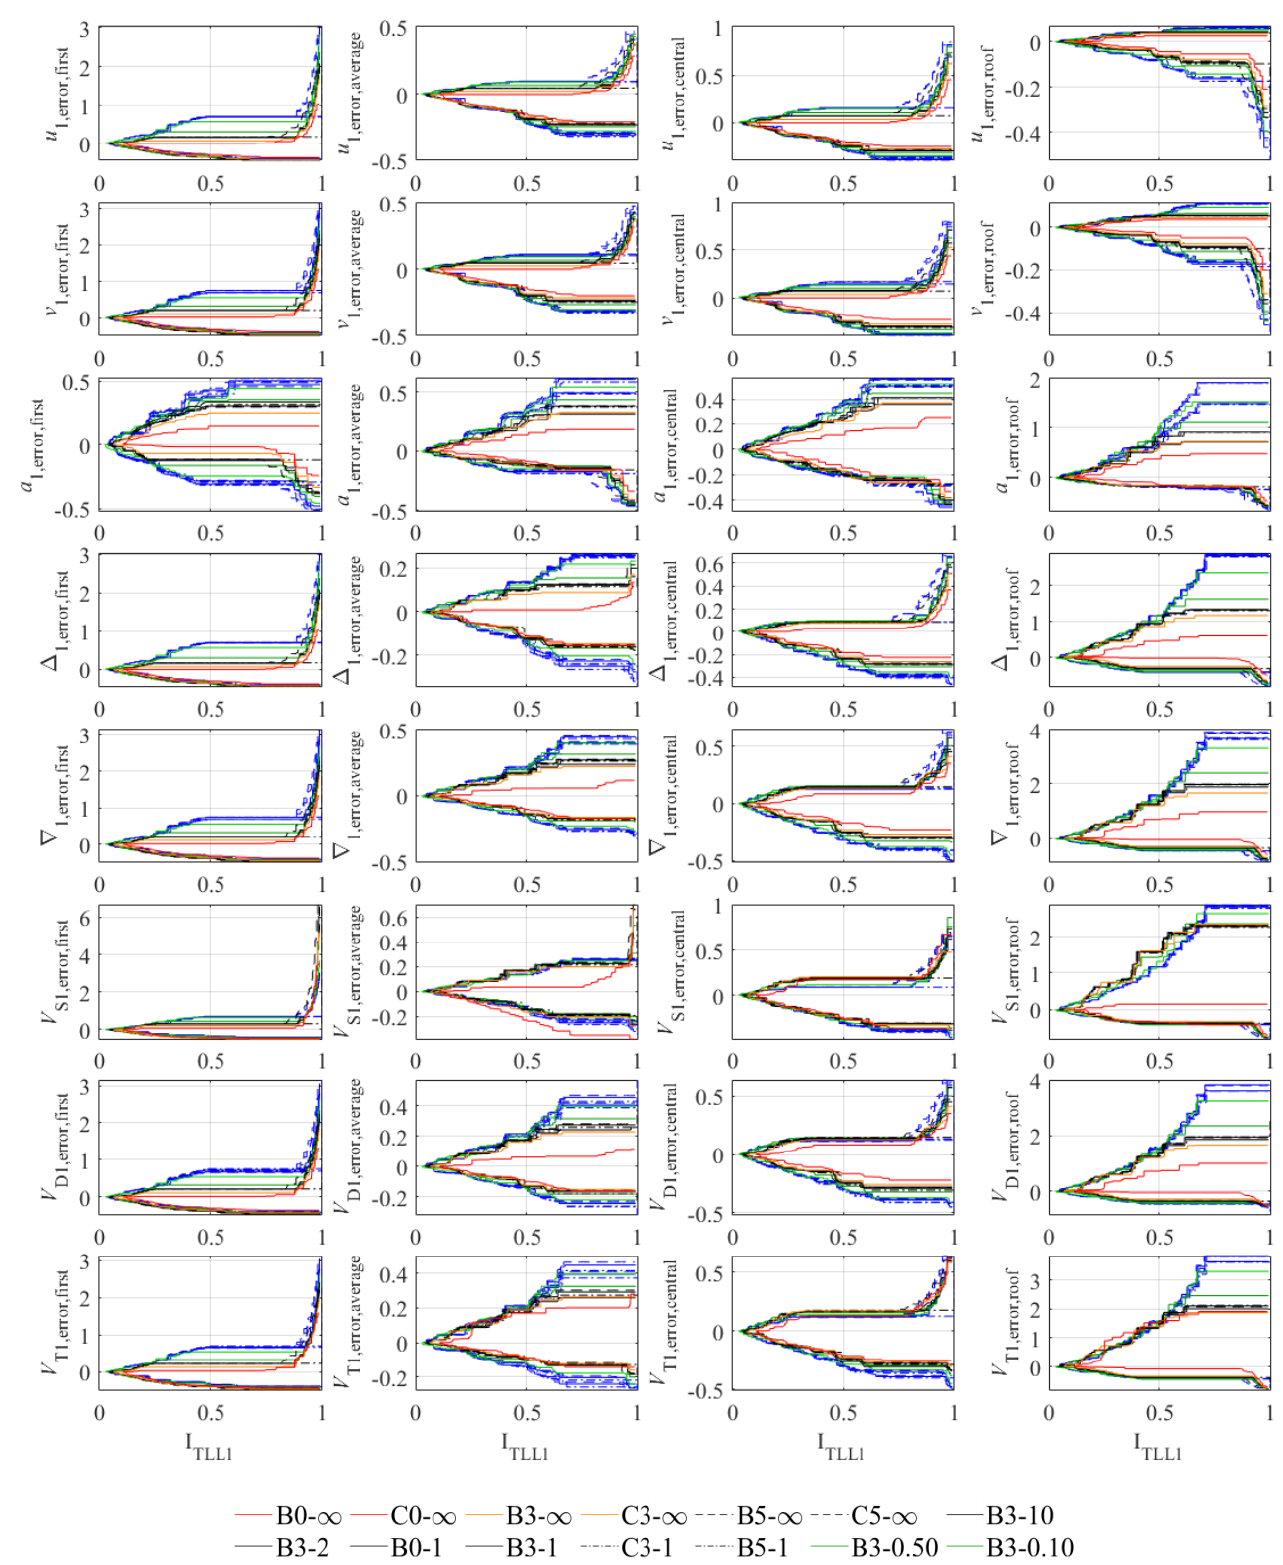
Figure 9. THMA error (type 1) max and min envelope for all cases versus index I TLL 1